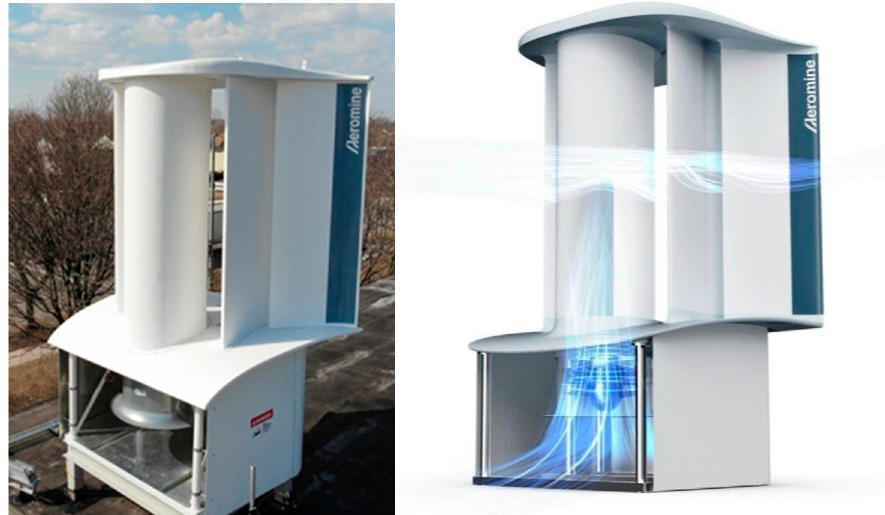
Figure 10. Illustration of the new wind converter and its working principle.